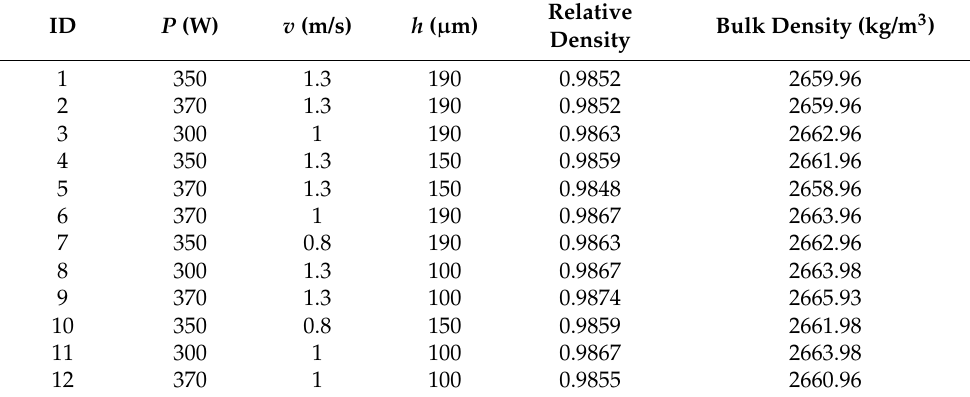
Table A6. Manufacturing parameters and experimental data, adapted from [20]. Complement- ing relevant information and assumptions are the following; material: Al6061, theoretical density